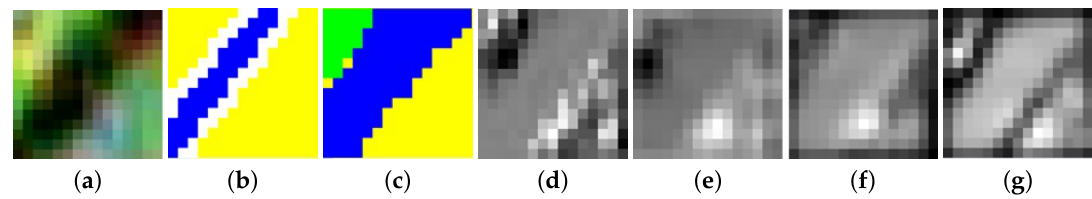
Figure 14. The visualization of multiple land cover data. ( a ) Pauli RGB image; ( b ) Classification result; ( c ) Ground truth map; ( d )Output of the conv1; ( e ) Output of the conv2; ( f ) Output of the conv3; ( g ) Output of the